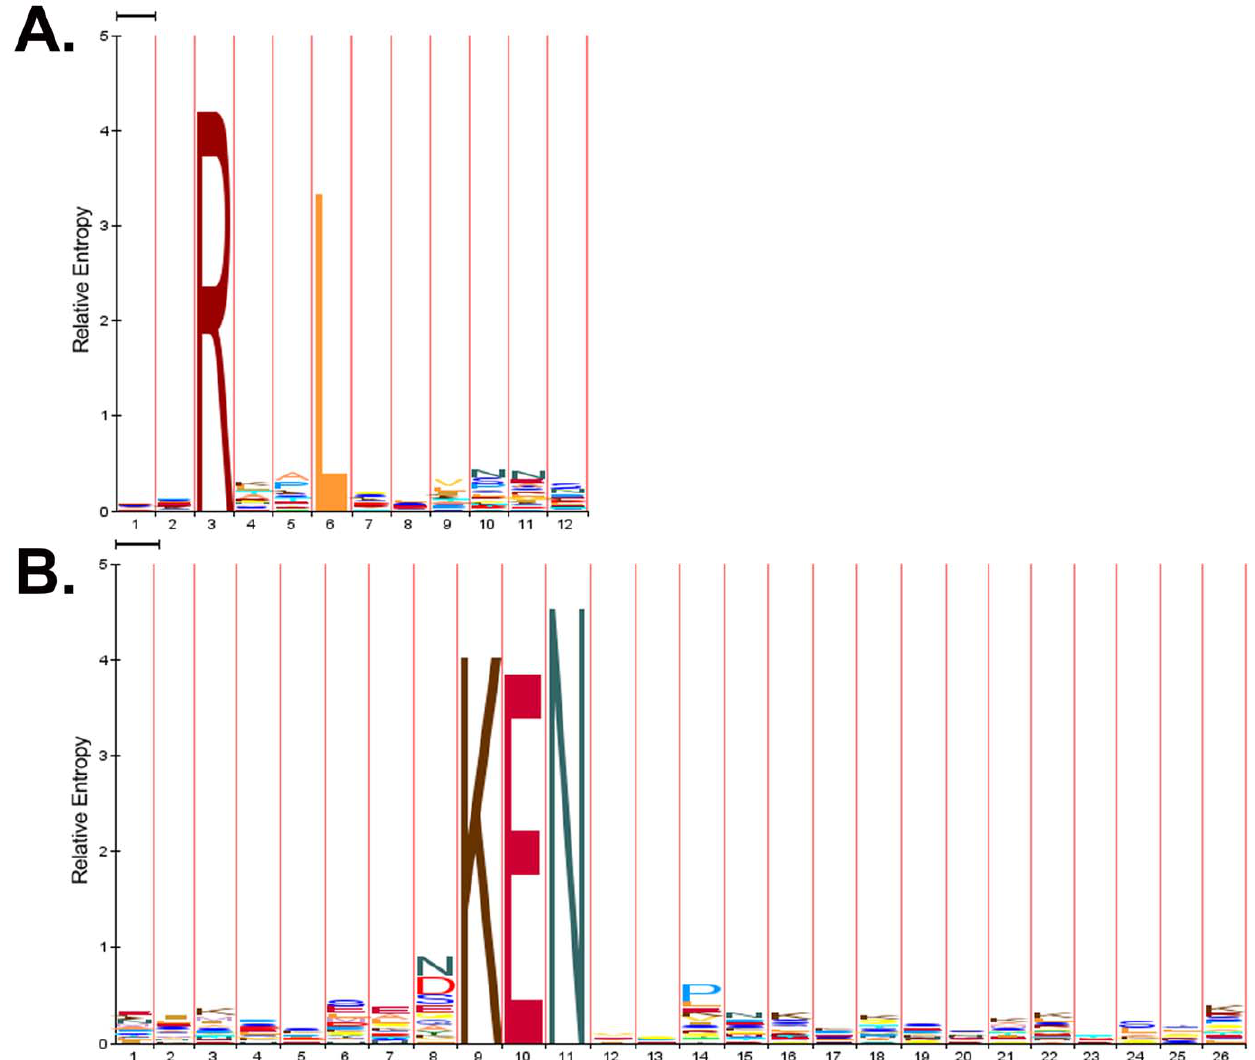
Figure 1. The Sequence logos of ARM(2, 6) and ARM(8, 15) were generated by the HMM-Logo (LogoMat-M) [ 31 ] for the (A) D-box and (B) KEN-box, respectively.